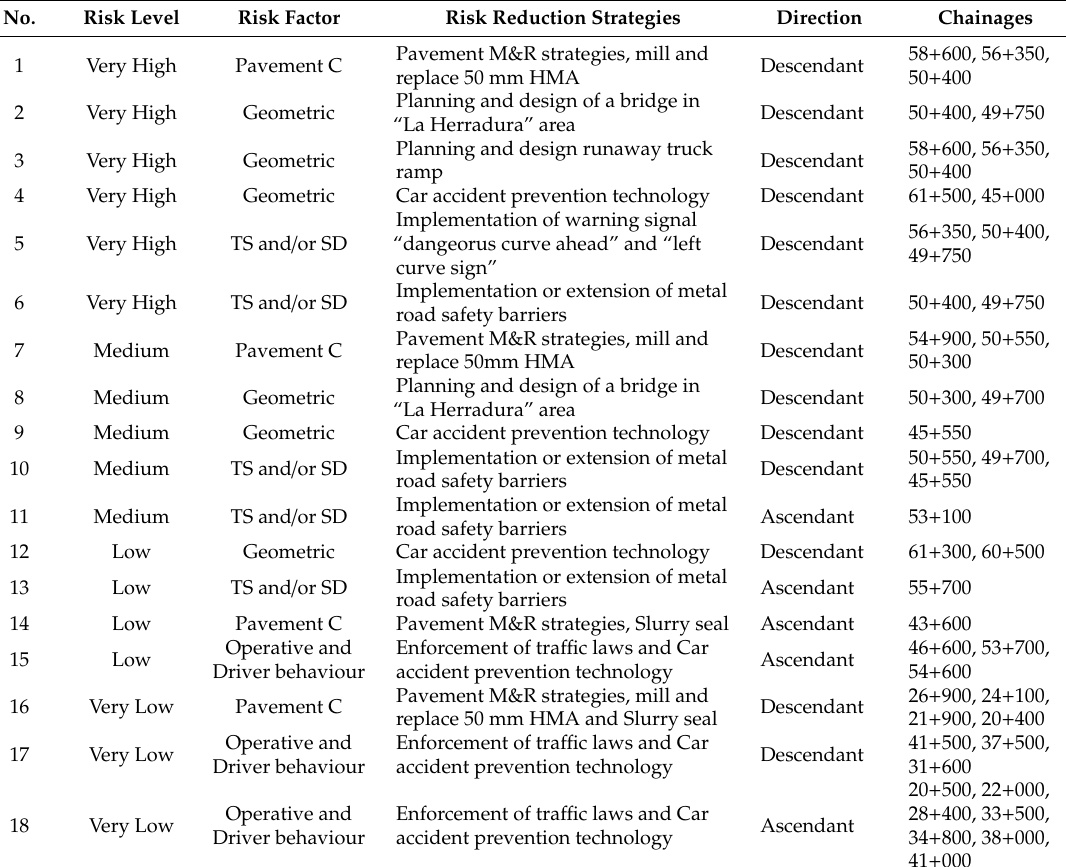
Table 8. Integrated risk reduction plan 1